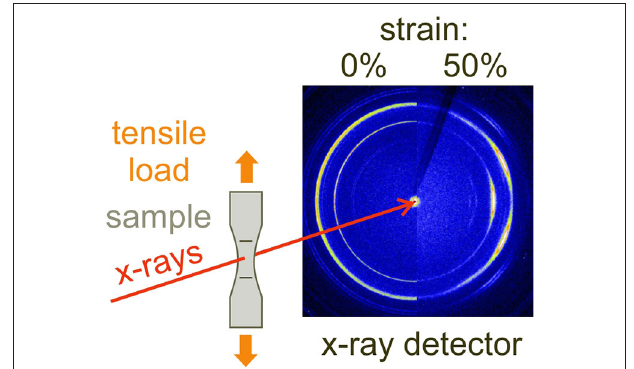
FIGURE 1 | Experimental in-situ X-ray scattering setup combined with mechanical tensile testing. Tensile load is applied to the sample, which is simultaneously scanned by an X-ray beam. Two-dimensional X-ray diffraction patterns are recorded by a two-dimensional detector (shown: two halves of diffraction patterns representing 0 and 50%